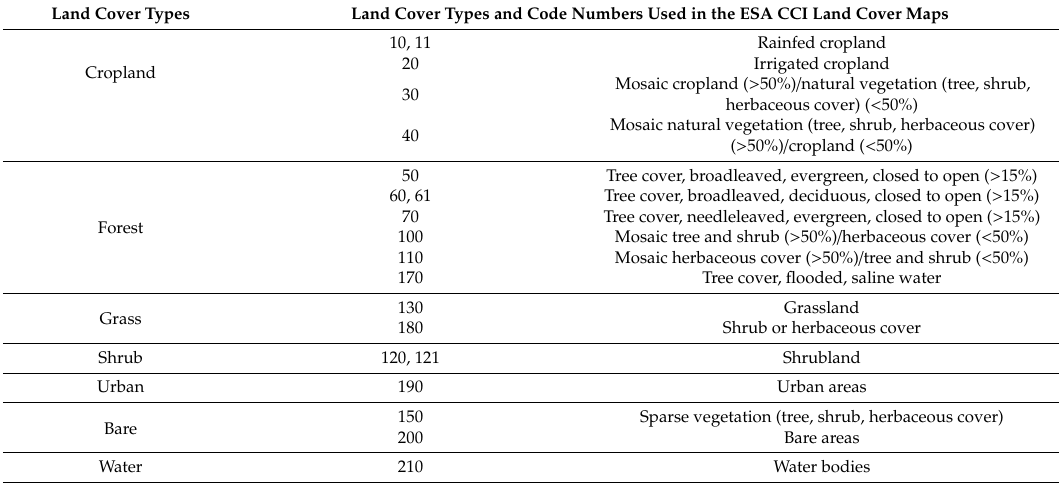
Table 1. Land cover classification of Jiangxi